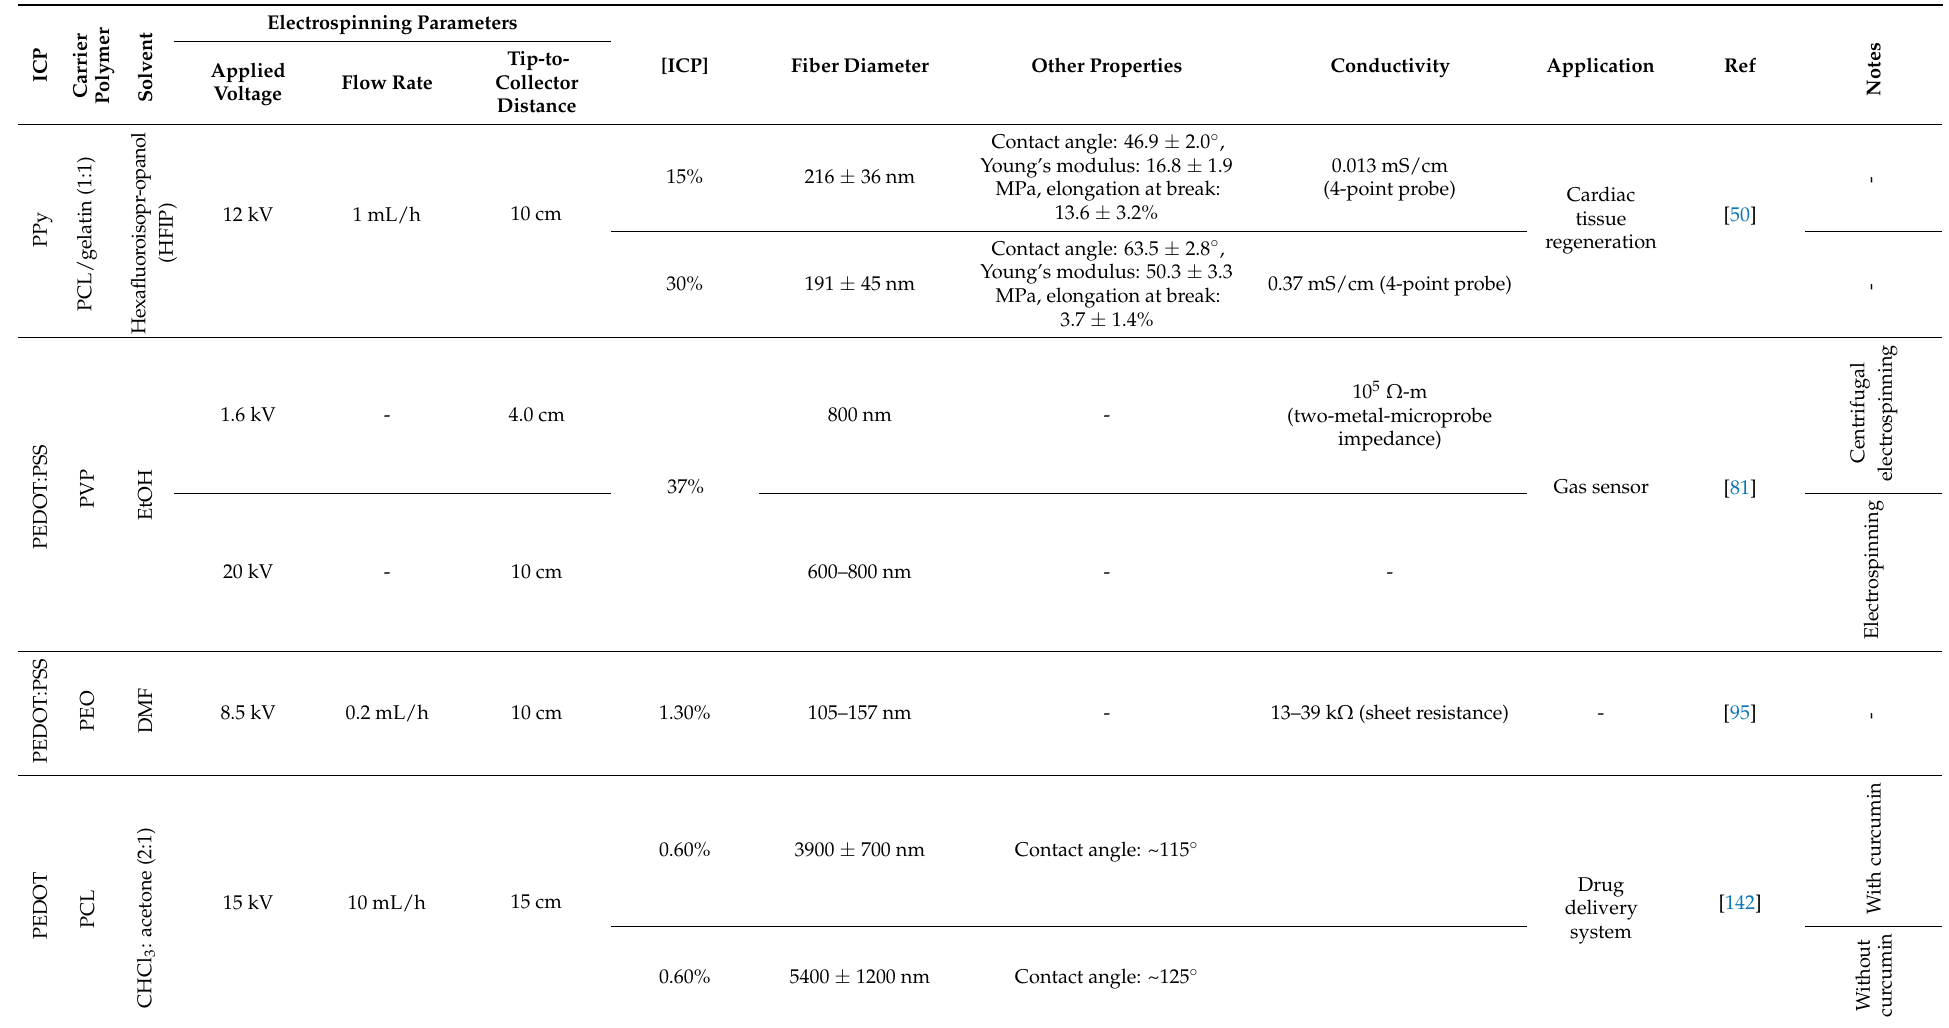
Table 3. Summary of reports of electrospinning using carrier